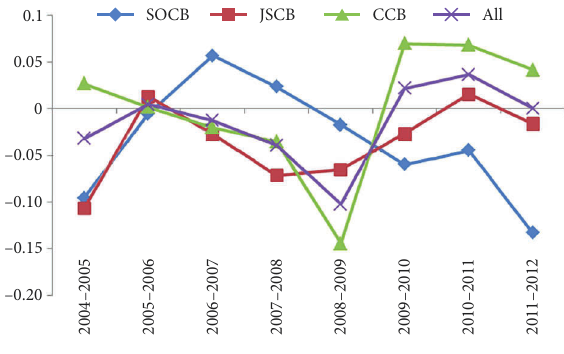
Figure 8. SEC gap